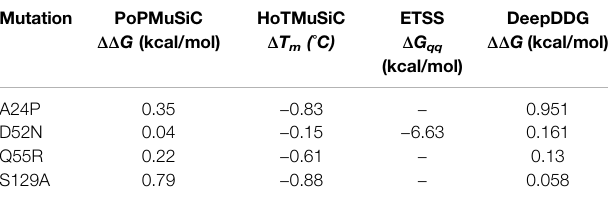
TABLE 4 | Mutations with improved thermostability predicted using PoPMuSiC, HoTMuSiC, ETSS and DeepDDG software programs.